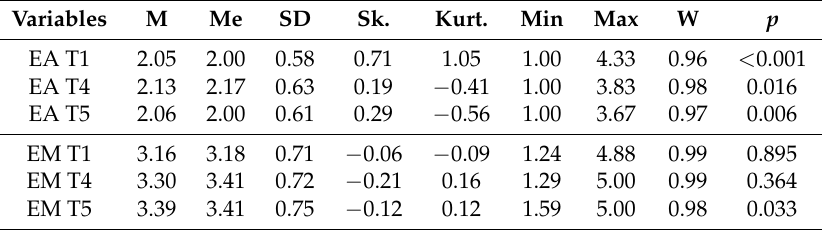
Table A2. Descriptive Statistics with the Shapriro–Wilk normality test for EM and EA at T0, T4, and